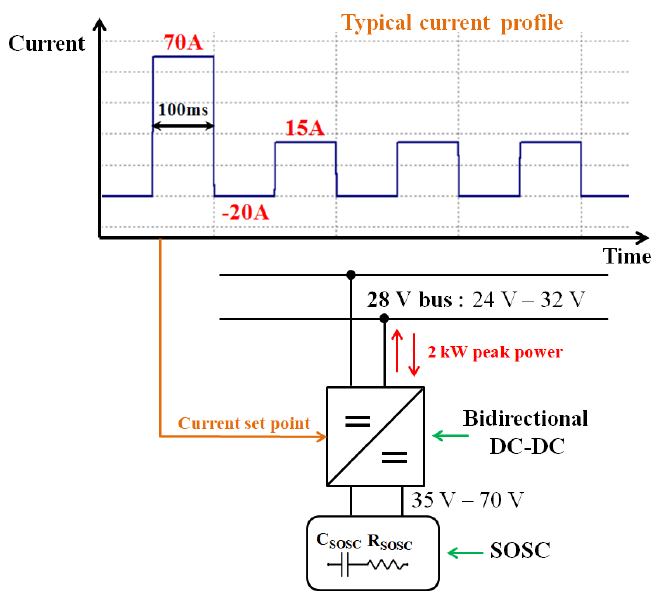
Figure 1. Power system architecture.